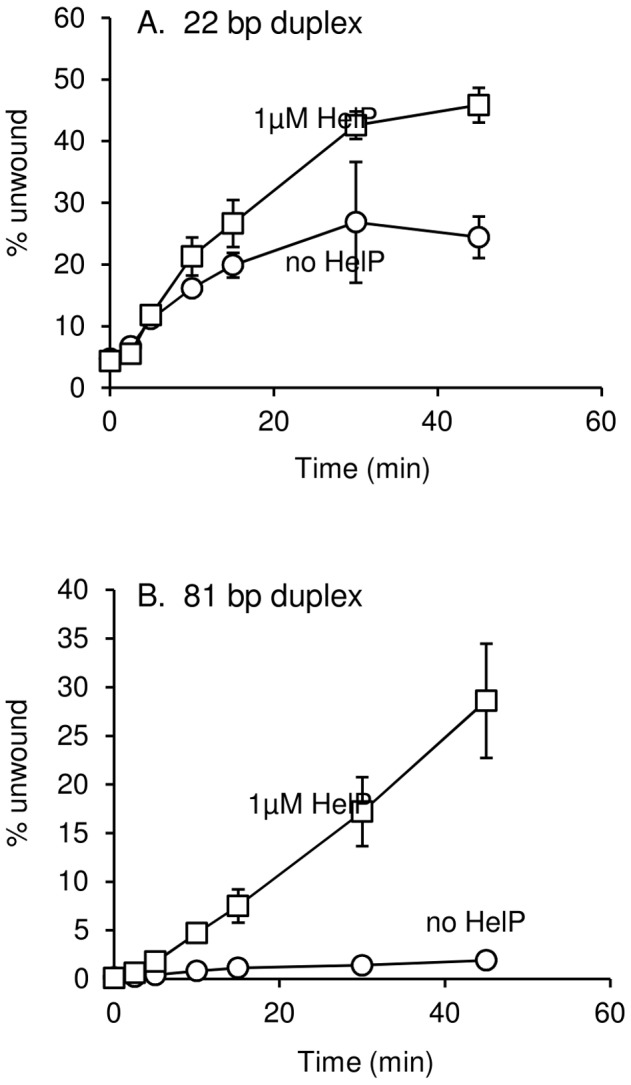
DNA unwinding by UvrD is stimulated by HelP.Substrates for unwinding were M13mp18 ssDNA annealed to either a 22 (A) or 81 (B) complementary fluorophore-labeled oligonucleotide. Data presented are the averages of three independent experiments ± standard deviation. Substrate unwinding was undetectable in the presence of HelP alone (<0.5% substrate unwound after 45 minutes) for both substrates. These controls were done with only the 45 minute time point.